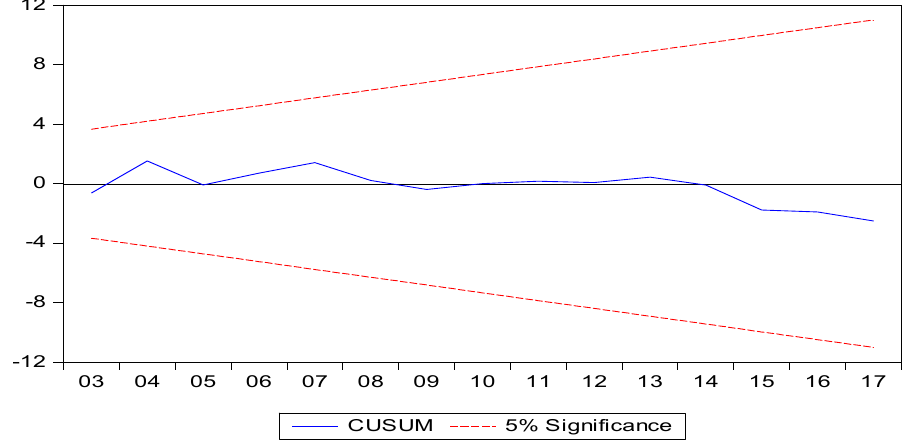
J. Risk Financial Manag. 2019 , 12 , x FOR PEER REVIEW 11 of 15 Figure 1. Represents the cumulative sum (CUSUM) . Figure 1. Represents the cumulative sum (CUSUM).